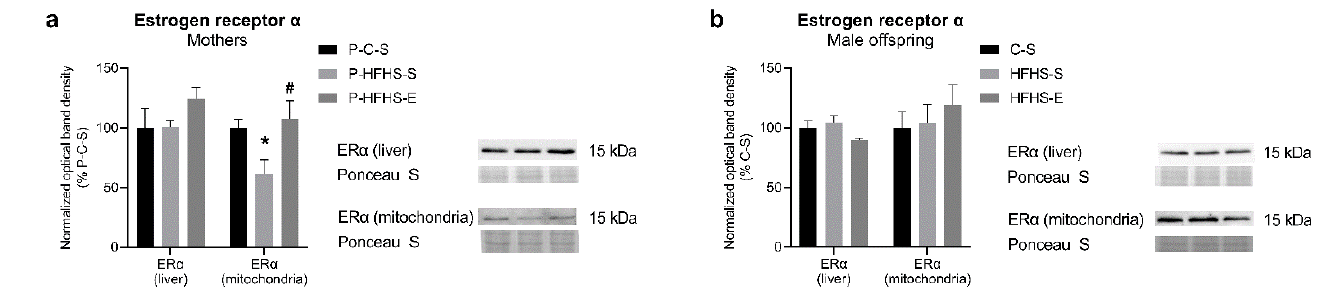
Figure 4. Effects of maternal HFHS and GE on the protein expression of ER α in the liver tissue and mitochondria of ( a ) maternal generation and ( b ) offspring generation. GE—gestational exercise; C—mothers fed with control diet; HFHS—mothers fed with high-fat high-sucrose diet; S—sedentary mothers; E—exercised mothers. * vs. P-C-S ( p < 0.05) or vs. C-S ( p < 0.05) in mothers or offspring, respectively. # vs. P-HFHS-S ( p < 0.05) or vs. HFHS-S ( p < 0.05) in mothers or offspring, respectively.